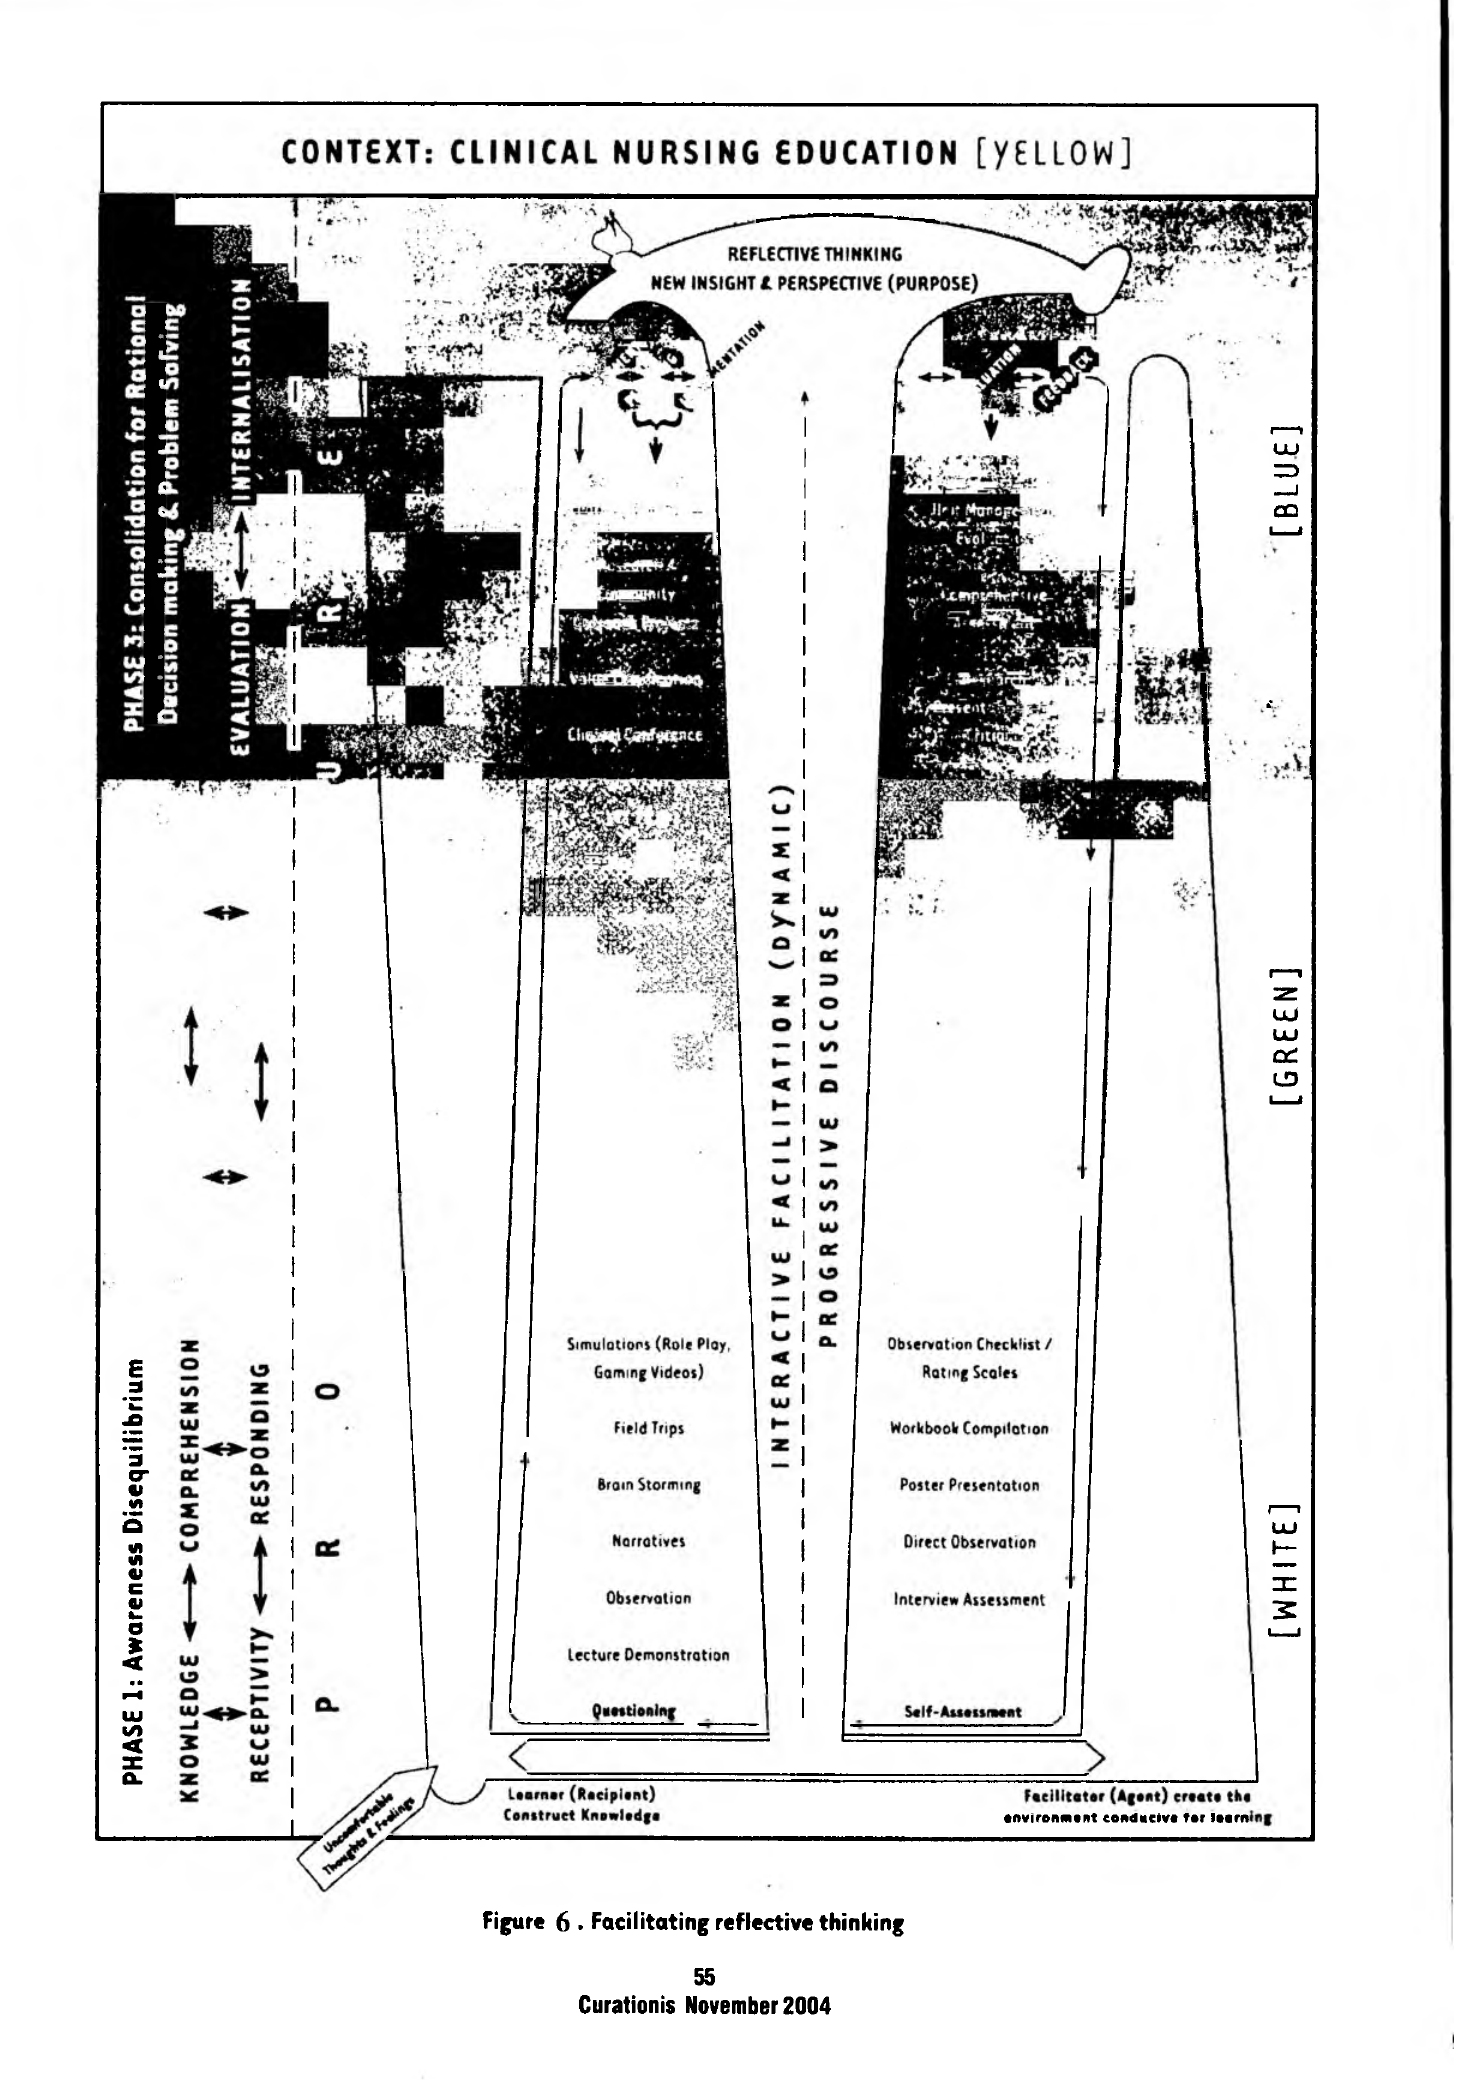
Figure 6 • Facilitating reflective